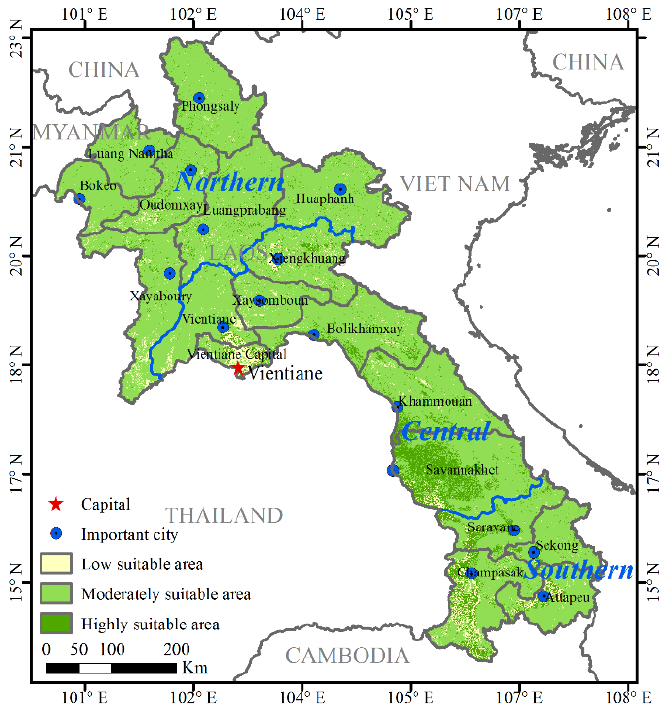
Figure 6. Spatial pattern of the natural suitability (or three sub ‐ categories) of human settlements using the HSI in Laos.